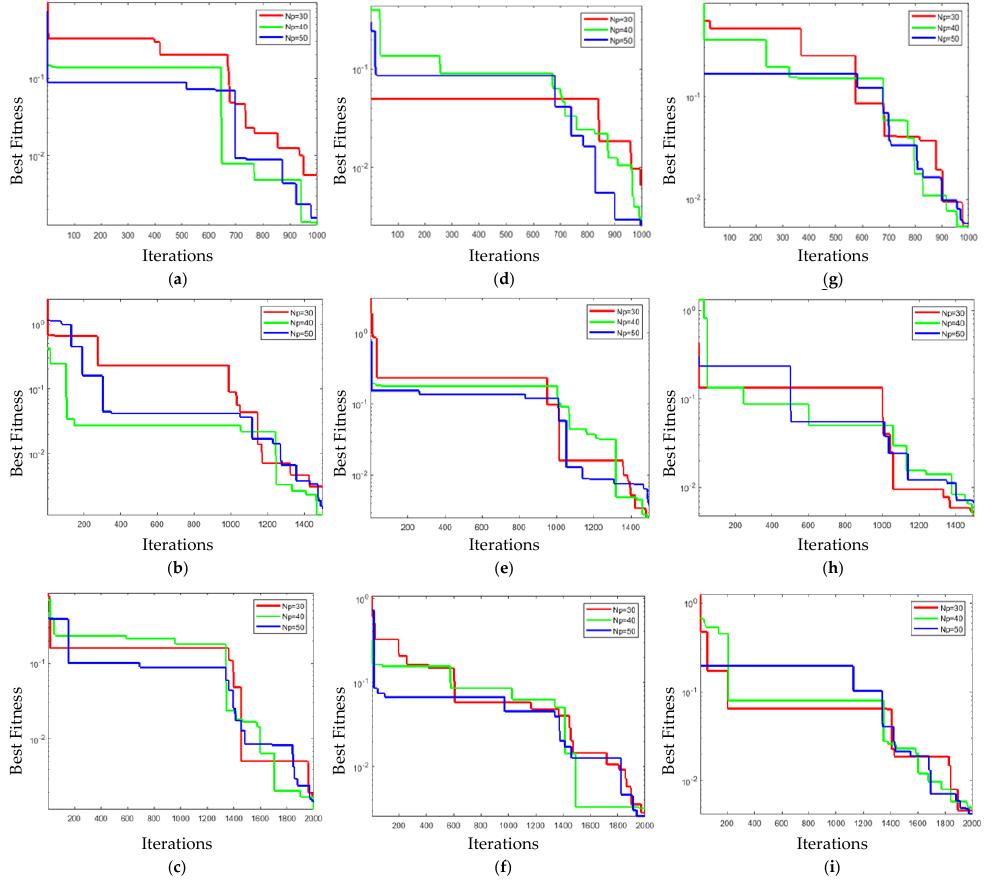
The performance of the AO method in terms of best fit for three noise levels, i.e., 0.04, 0.06, and 0.08, is evaluated for the three variations in a generation, 1000, 1500, and 2000, and population size, 30, 40, and 50. Figure 5 shows the fitness plots. The fitness curves in Figure 5a–c represent the best fit of the AO algorithm for noise variance = 0.04. In contrast, Figure 5d–e show the best fit curves for noise variance = 0.06. Likewise, the best fit plots for noise variance = 0.08 are given in Figure 5g–i. Figure 5a–i shows that the AO fit for the three noise levels, i.e., 0.04, 0.06, and 0.08, decreases significantly with increasing genera- tion and population size as well. However, better fit results are achieved for smaller values of noise with a greater number of generations and populations.